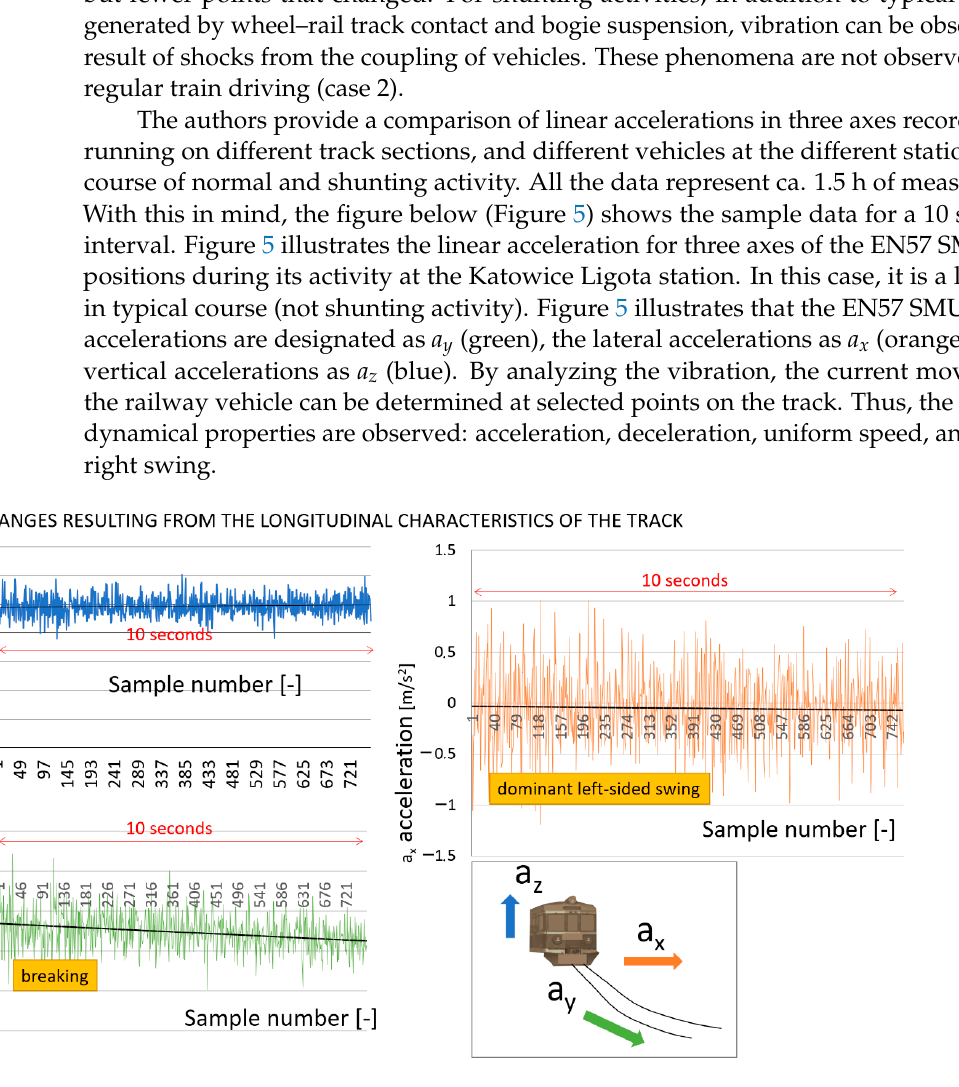
color). Figure 6. Visualization of example data from the output file containing linear accelerations. Locomotive sample shunting run in a track section featuring switches. Source: authors’ own materials. Based on the comparison of Figures 5 and 6—linear accelerations recorded while running on different sections of the track at the station in the course of the activity of the railway vehicle—we can generalize some conclusions. Figures 5 and 6 provide a collation of linear accelerations recorded in a smaller fragment of the track (with and without